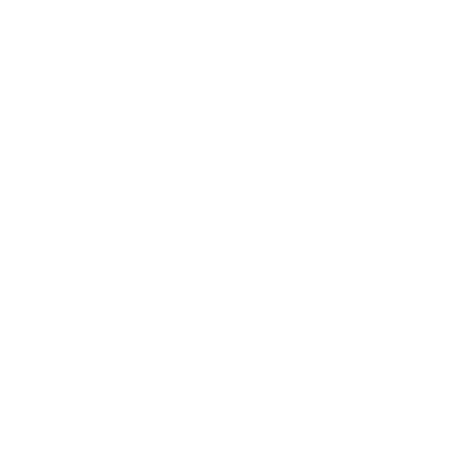
Figure 2. Sputum Biomarkers in COPD Stable and Exacerbating Samples : ( a ) IL-1 β , data is pre- sented as paired concentrations, data analysed using Wilcoxon signed rank test. ** p ≤ 0.01. ( b ) IL-6, data is presented as paired concentrations, data analysed using a paired t -test. * p < 0.05. ( c ) TNF- α , data is presented as paired concentrations, data analysed using Wilcoxon signed rank test. ** p < 0.01. ( d ) IL-8, data is presented as paired concentrations. ( e ) MPO, data is presented as paired con- centrations. 3.2.2. Cohort B The baseline characteristics for 81 COPD patients, 15 HS and 26 HNS are presented in Table 3. COPD patients were significantly older than HS and HNS ( p = 0.04 and <0.01, respectively). In the COPD group, the mean FEV 1 % predicted was 64.7%, while mean CAT and total SGRQ scores were 19.7 and 50.3, respectively. The historical mean exacer- bation rate/year was 1.0. Table 3. Baseline characteristics for COPD subjects, healthy smoking and healthy non-smoking con- trols in Cohort B ( n = 81, 15 and 26, respectively *). Characteristics